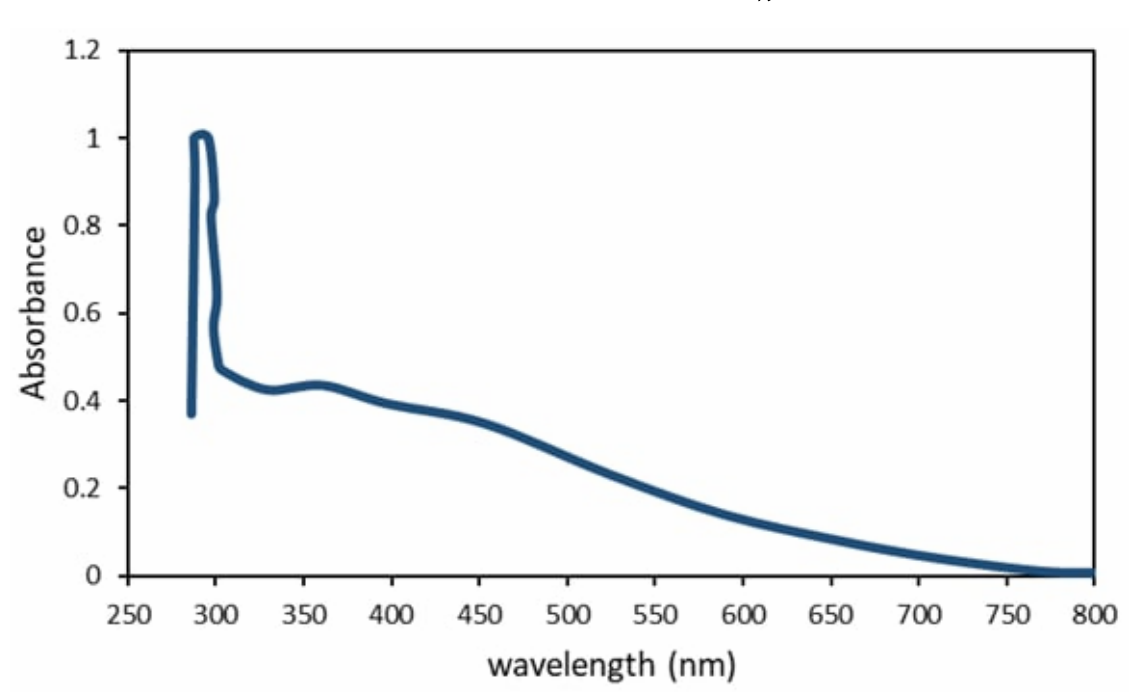
Figure 10. Absorption spectrum of TiO 2 .